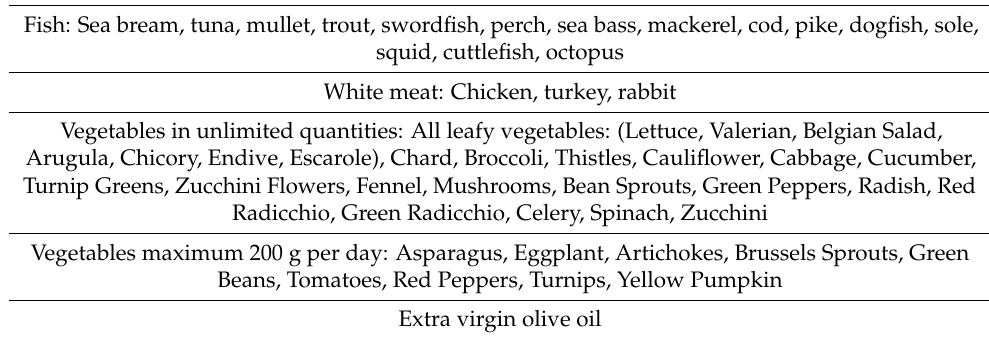
Table 2. VLCKD_MED food